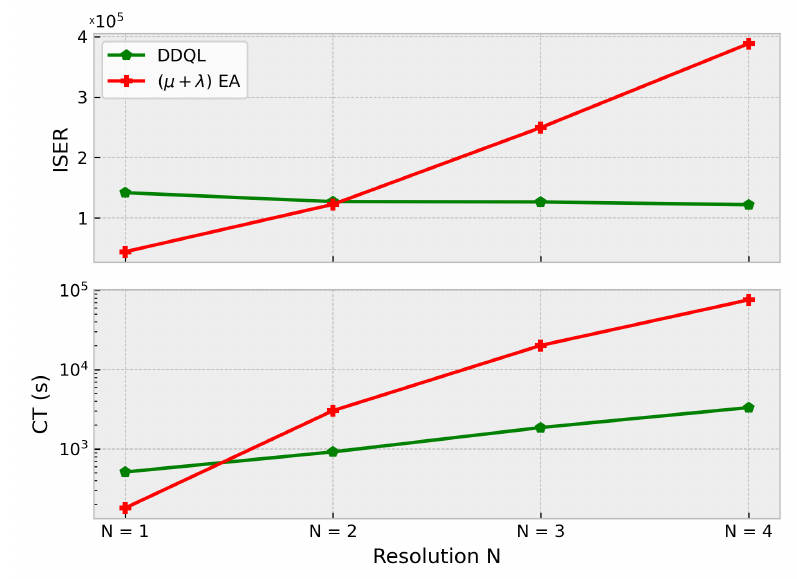
Figure 15. ISER ( up ) and CT ( down ) for each approach and every resolution